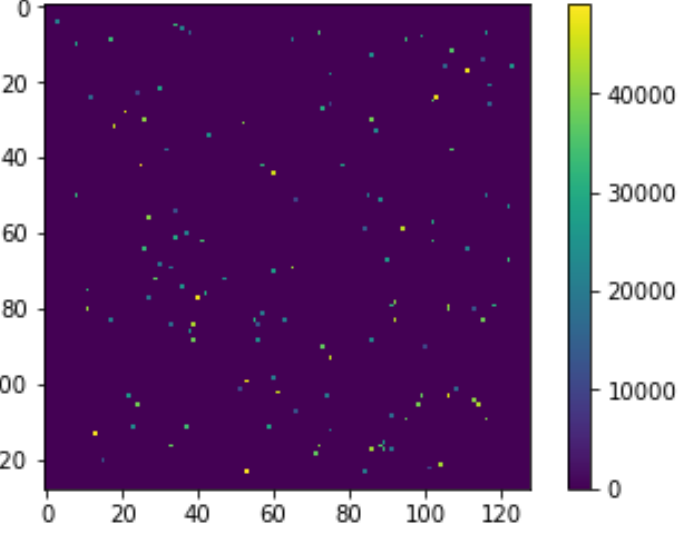
Figure 2. Sample reference